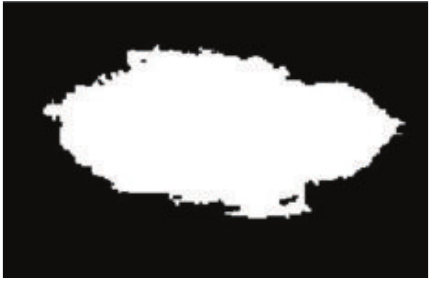
Figure 4: Segmentation result of maize leaf